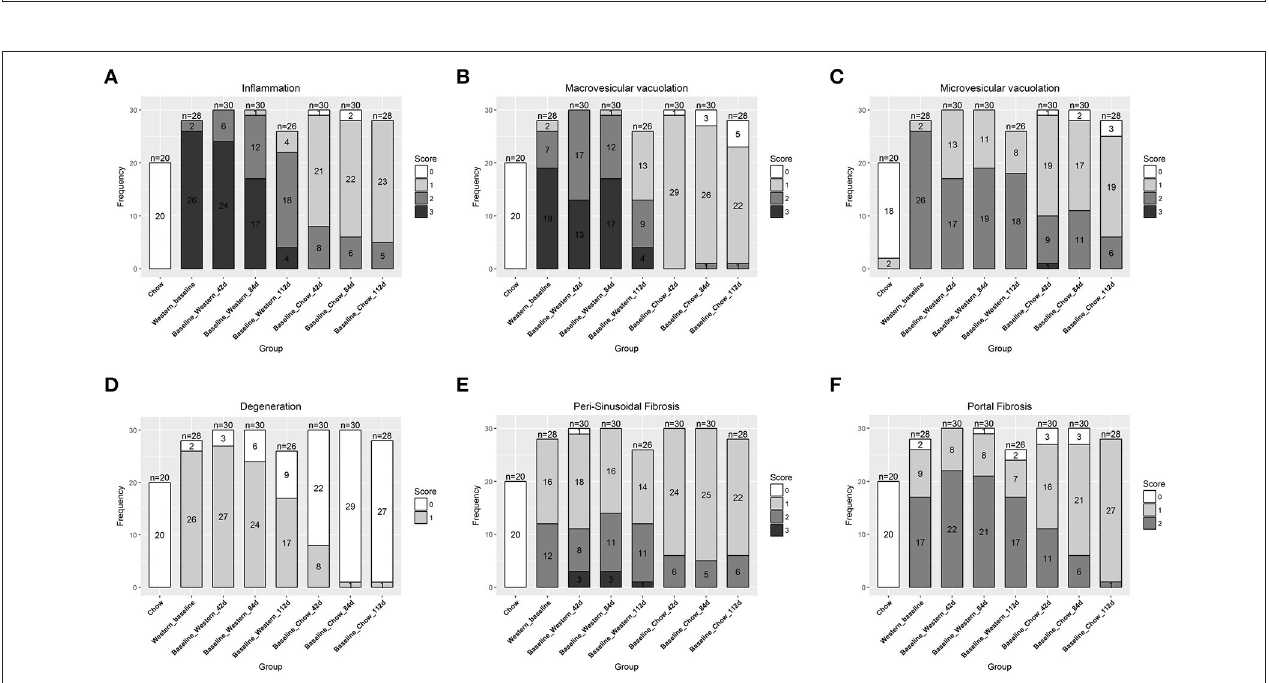
FIGURE 5 | Regression of hepatic lesions in the NASH mice after the Western diet was replaced by chow. At different time after the dietary replacement, the right and left lateral lobes of the NASH mice were collected, and analyzed. The pathological scores from both lobes of an animal were pooled when performing categorical analysis. Hepatic inflammation (A) , macrovesicular vacuolation (B) , microvesicular vacuolation (C) , hepatocyte degeneration (D) , perisinusoidal fibrosis (E) , and portal fibrosis (F) were graded. Bridging fibrosis was also analyzed, but absent in all the animals.